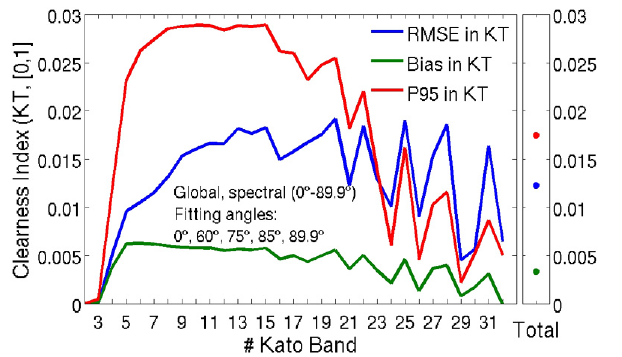
Figure 4. Errors for KT glo for Kato bands and total (piecewise